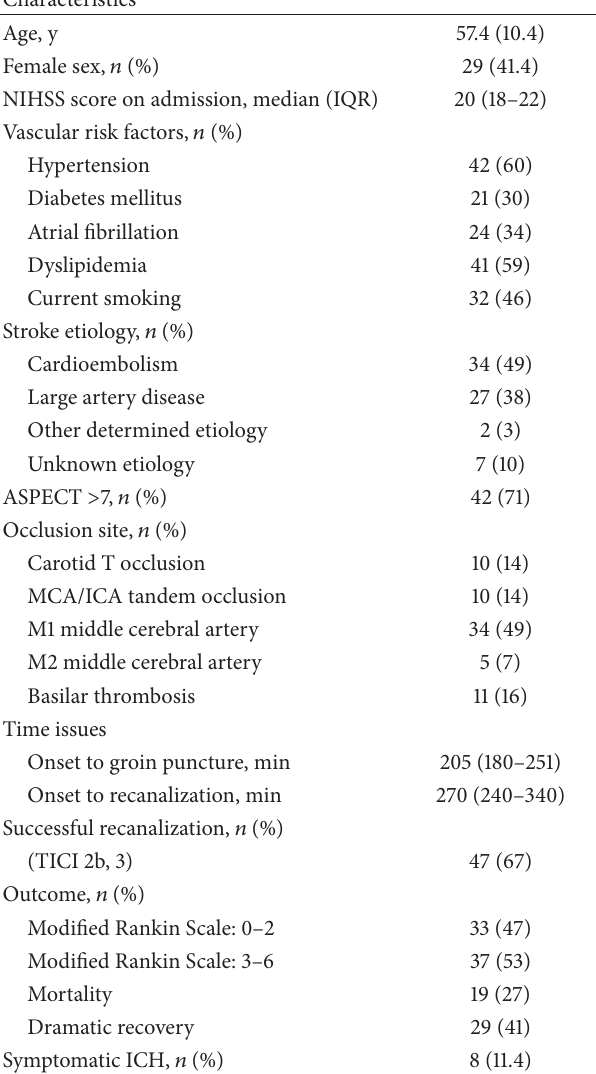
Table 2: Baseline characteristics and procedural parameters of all